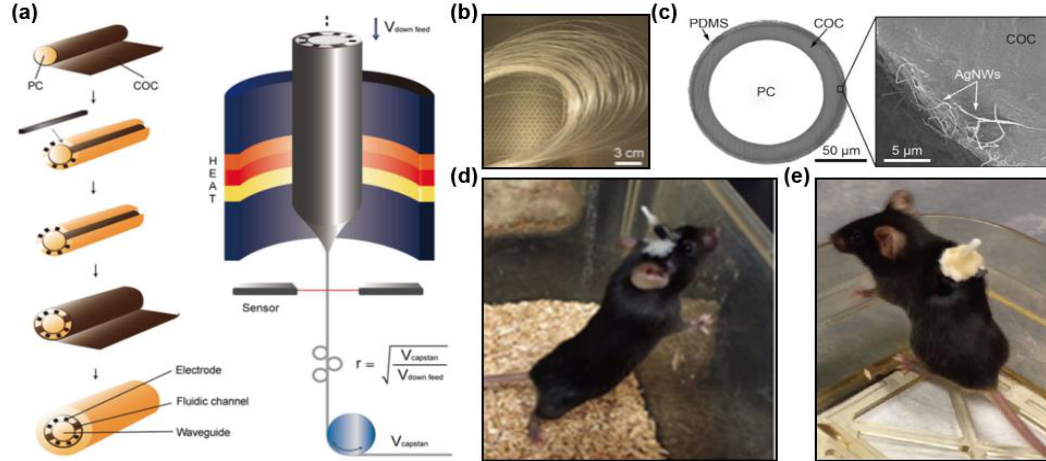
Figure 6. Hybrid, multifunctional fibers. ( a ) Steps involved in the fabrication of multifunctional fiber device. Reproduced with permission [72]. Copyright 2017, Nature Publishing Group. ( b ) Multifunctional fiber spools. Reproduced with permission [74]. Copyright 2017. AAAS. ( c ) Cross-sectional view of the fiber (right panel) and SEM image of the AgNW electrodes (left panel). Reproduced with permission [74]. Copyright 2017, AAAS. ( d , e ) Living mice with the implanted fiber probes in the brain and spiral cord, respectively. Reproduced with permission [72,74]. Copyright 2017, Nature Publishing Group and